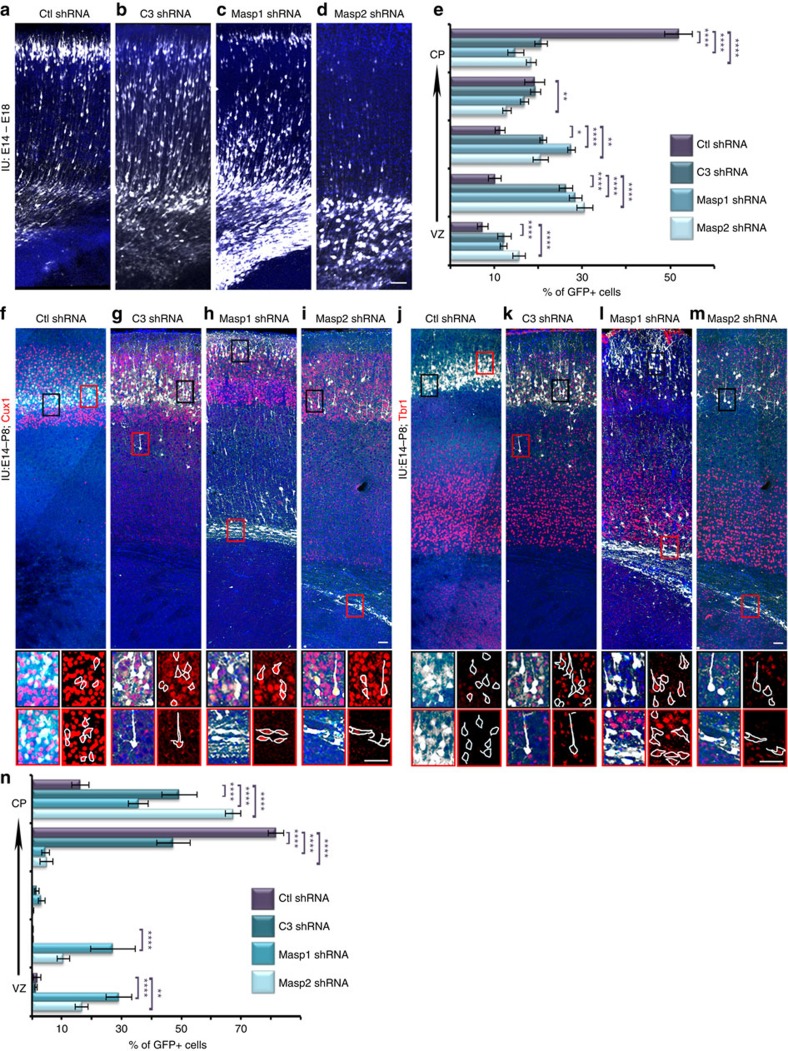
C3, Masp1 and Masp2 knockdown affect neuronal migration.(a–e) Brains were electroporated in utero (E14–E18) with control shRNA (a, n=4), C3 shRNA (b, n=5), Masp1 shRNA (c, n=5) or Masp2 shRNA (d, n=4). The scale bars are 50 μm. (e) The position of GFP+ neurons across the width of the cortex was analysed and is shown in five bins (from the VZ to the CP). All shRNA treatments were compared to control shRNA. (f–n) Postnatal positioning and the identity of C3, Masp1 and Masp2 knockdown cells. Brains electroporated in utero on E14 with control shRNA (f,j), C3 shRNA (g,k), Masp1 shRNA (h,l) or Masp2 shRNA (i,m) were immunostained at postnatal day 8 (P8) with anti-CUX1 or anti-TBR1 antibodies (f–i,j–m, respectively). Black and red boxes show the position of the enlargements underneath each slice. The immunostainings for the enlarged areas are shown together with GFP or with the outlines of GFP-positive cells. (n) The position of GFP+ neurons across the width of the P8 cortex was analysed and is shown in five bins (from the VZ to the CP). All shRNA treatments were compared to control shRNA. The scale bars are 50 μm. *P<0.05; **P<0.01; ***P<0.001; ****P<0.0001, histograms present means±s.e.m.